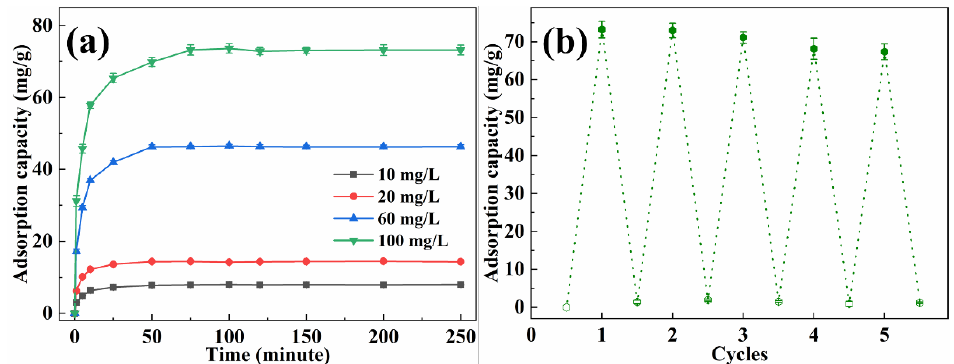
Figure 7. ( a ) The adsorption capacity of EP-3 for methyl orange with various concentrations; ( b ) recyclability test of